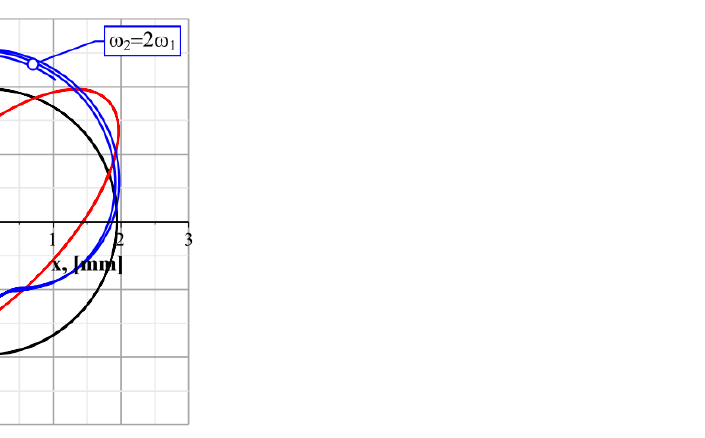
( с ) Figure 5. Time dependence of the electric motor’s shaft torque at different synchronization condi- tions of the unbalanced rotors. ( a ) 𝜔 2 = 𝜔 1 ; ( b ) 𝜔 2 = −𝜔 1 ; ( c ) 𝜔 2 = 2𝜔 1 . Under the conditions of equal angular speeds of the unbalanced rotors ( 𝜔 2 = 𝜔 1 ), the traditional single-frequency oscillations are excited and the circular motion trajectories of the system’s mass center are described in Figure 6. In this case, the disturbing force is